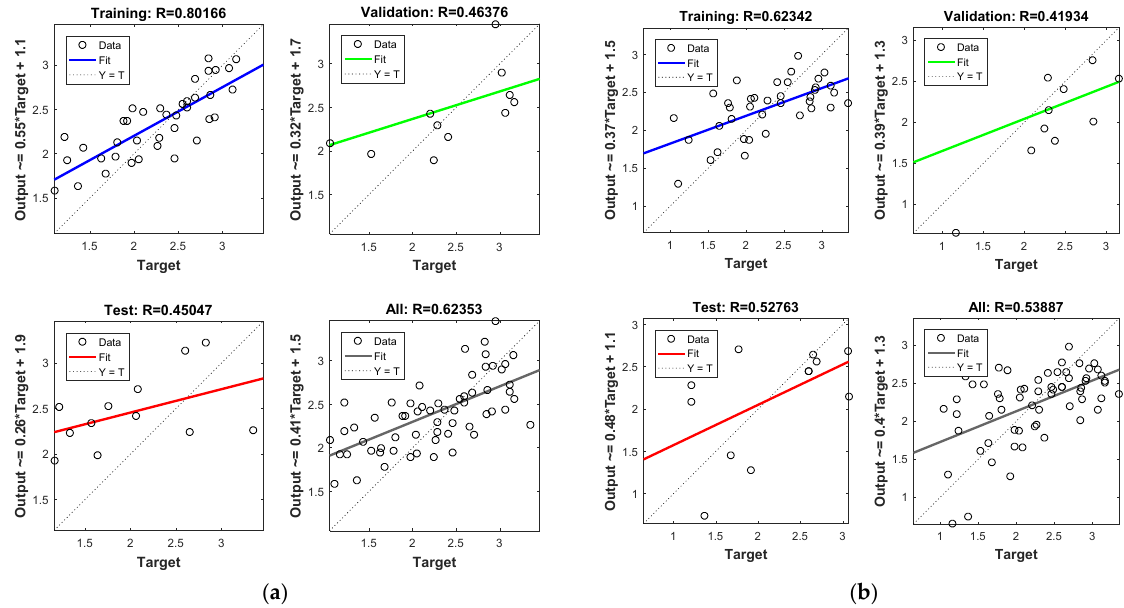
Figure 3. NARX ( a ) and FTD ( b ) neural network training, validation, and testing performance. Note that the best validation performance for the NARX model was 0.388 at epoch 3, and for the FDR model, it was 0.276 at epoch 3.